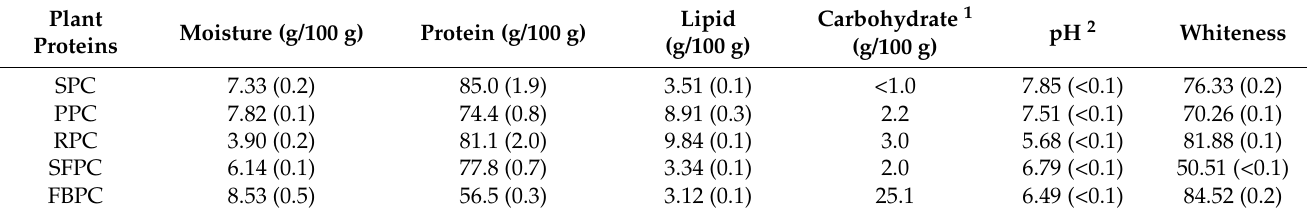
Table 2. Mean values (standard deviation) for physicochemical results of plant